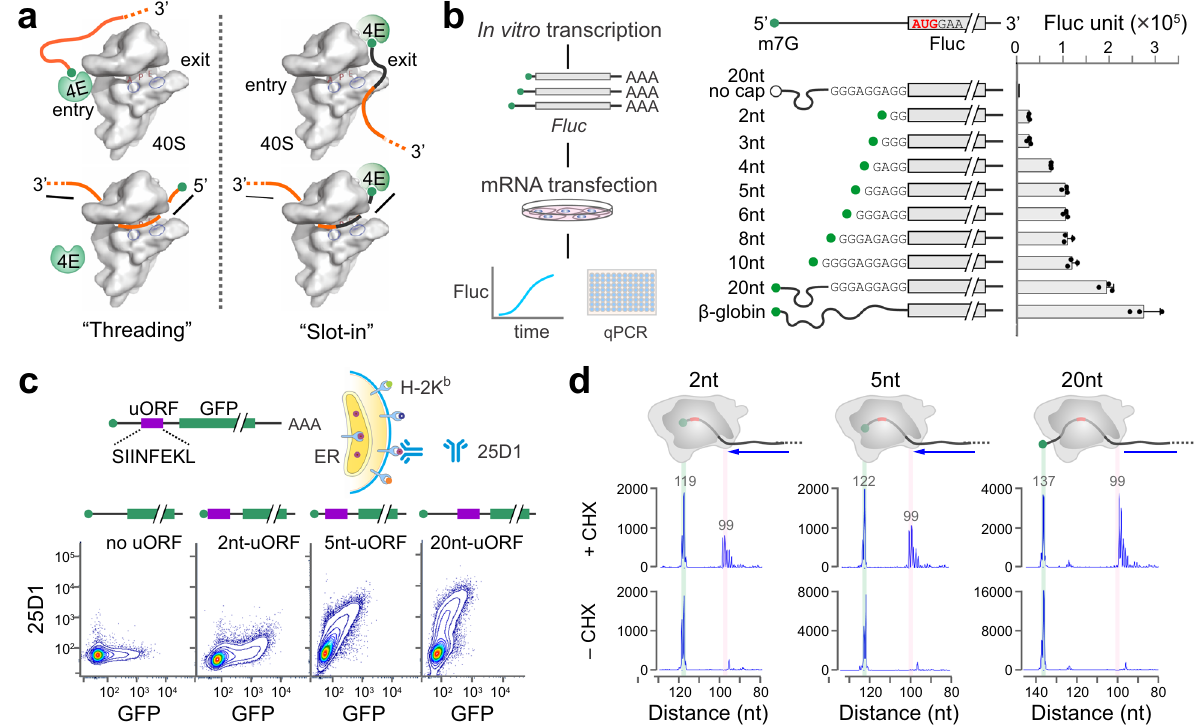
Fig. 1 Selection of start codons near the 5 ʹ end cap of mRNAs. a Schematic of mRNA entering the 40S via the ‘ threading ’ mode (left) or the ‘ slot-in ’ mode (right). Only eIF4E is shown for simplicity. The black portion of mRNA indicates the blind spot. b Translation ef fi ciency of Fluc mRNA reporters bearing ultra-short 5 ʹ UTR. The left panel shows the schematic of Real-time Luciferase Assay. In vitro synthesized mRNAs were transfected into MEF cells and Fluc activities were monitored by real-time luminometry. Fluc activities at 6 h were normalized to mRNA levels quanti fi ed by RT-qPCR. Uncapped mRNAs were included as negative control. Error bars: mean ± SEM; n = 3 biological replicates. c Translation ef fi ciency of uORF mRNA reporters bearing ultra-short 5 ʹ UTR. The top panel shows the schematic of uORF reporter assay coupled with FACS. The uORF reporter contains a sequence encoding SIINFEKL (purple) followed by GFP (green). Synthesized mRNA reporters were transfected into HEK293-K b cells, followed by measurement of 25D1 and GFP using fl ow cytometry. The bottom panel shows the representative fl ow cytometry scatterplots of HEK293-K b cells transfected with uORF reporters with a varied length of 5 ʹ UTR. mRNAs with no uORF were included as negative control. d Start codon recognition by toe-printing assays. Fluc mRNA reporters with varied length of 5 ʹ UTR were incubated in RRL, followed by reverse transcription using a probe downstream of the start codon. Expected positions corresponding to the full length and the ribosome leading edge are highlighted. Source data are provided as a Source Data fi